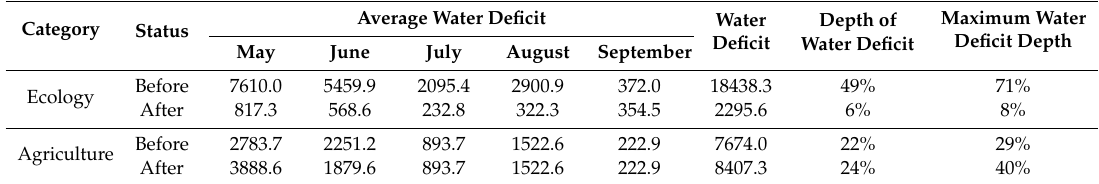
Table 1. The water deficits before and after decision reversal in θ =